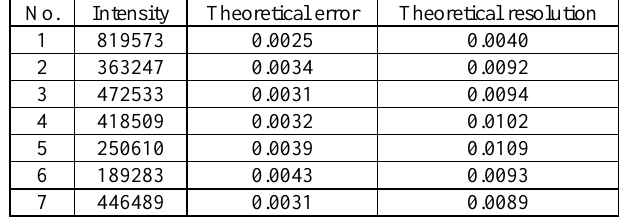
Table 5 Theoretical values of errors and